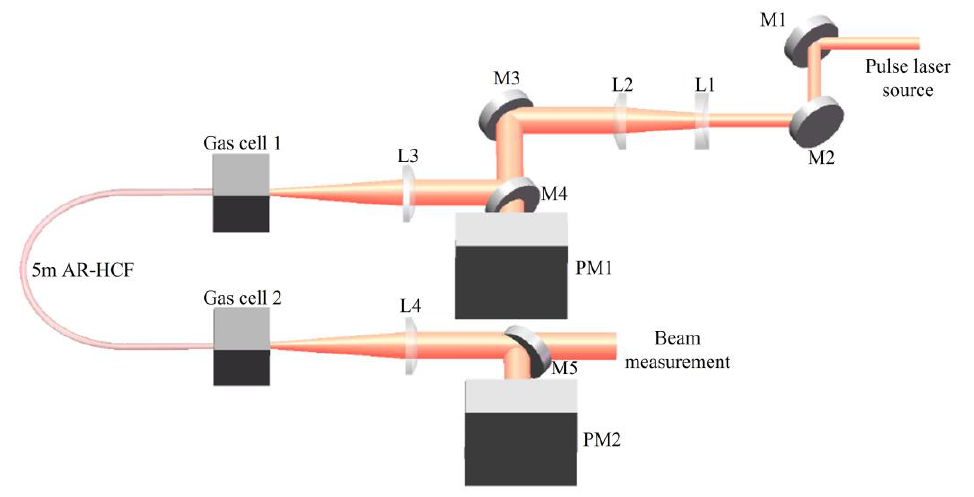
Figure 1. Measured attenuation of AR-HCF by a cut-back from 100 m to 10 m. Inset: SEM picture of AR-HCF. The core diameter is about 33 µ m.